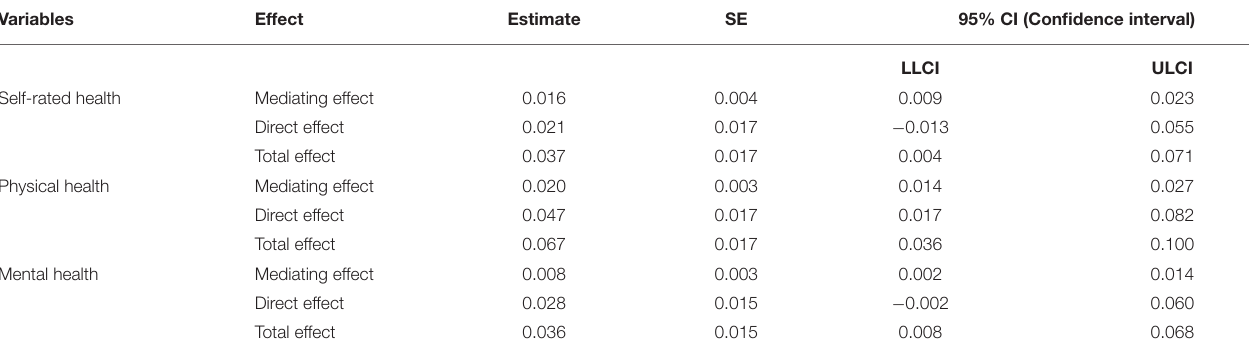
TABLE 8 | The mediating effect of cultural